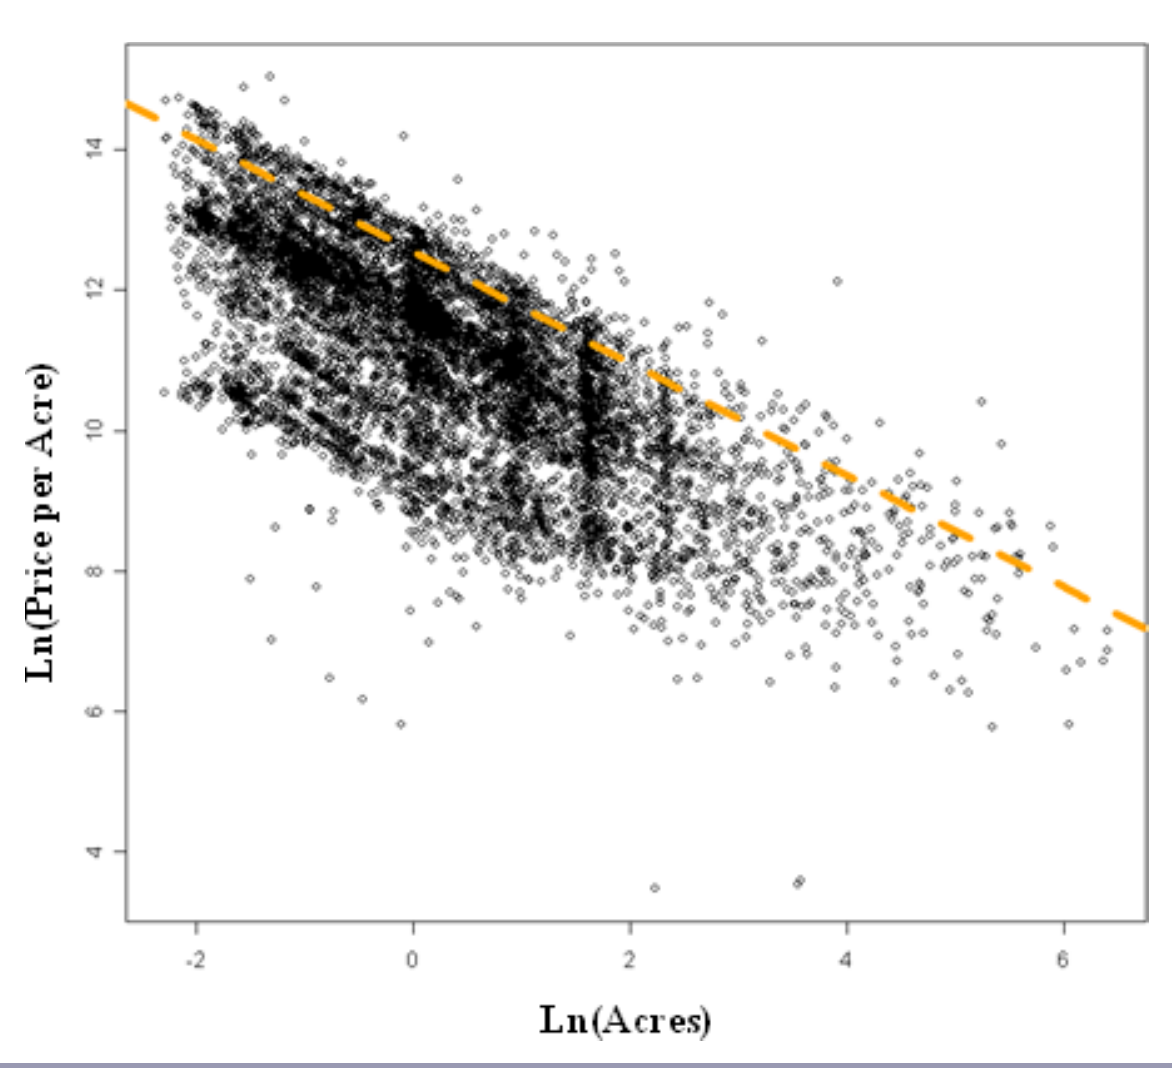
Fig. 3. Graph showing the relationship between the natural log area of a given parcel (bottom axis) and the natural log price per acre (left axis). Note larger parcels tend to cost less per acre. The dashed orange line is the 90% quantile regression line, which models this relationship between parcel area and parcel cost, accounting for inflation in land values over